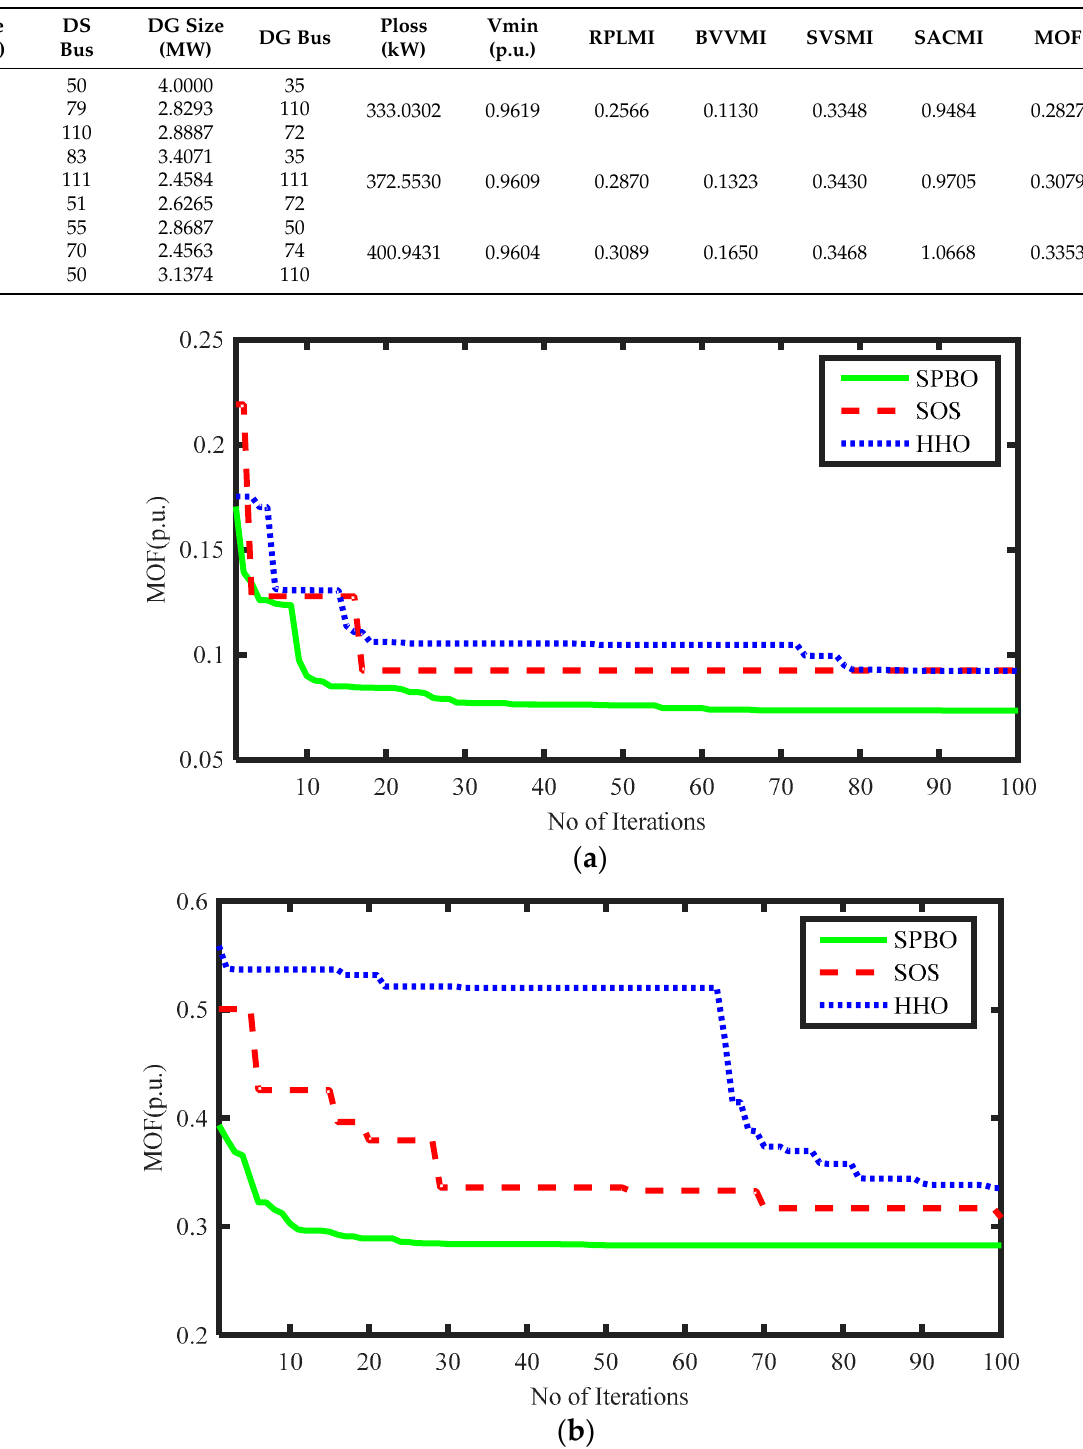
Figure 8. CC of optimization algorithms for case-7. ( a ) 33-bus test system; ( b ) 118-bus test system. The results of simultaneous allocation of D-STATCOMs and one PV-DG and two GT- DGs using the SPBO, SOS, and HHO algorithms are presented in Tables 15 and 16 for both test systems. The optimal effective sizes of the D-STATCOMs and DGs are (1.1024 MVAr, 3.0533 MW), (1.3173 MVAr, 3.3508 MW), and (0.2186 MVAr, 3.2191 MW) for the 33-node